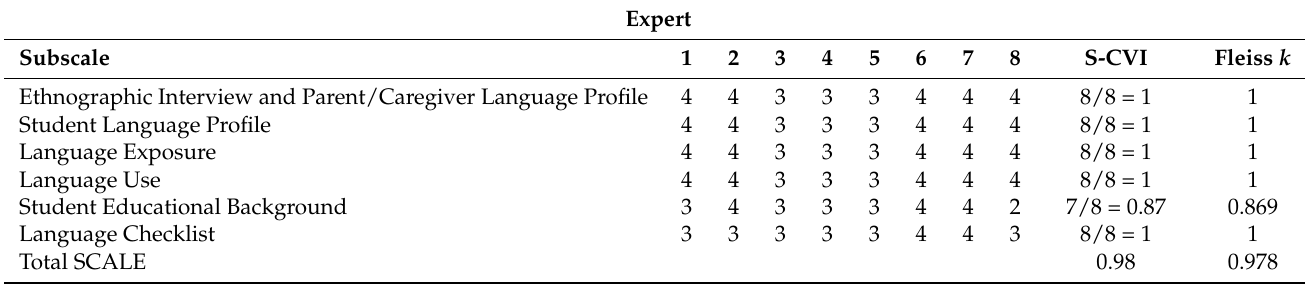
Table 9. Expert Ratings on